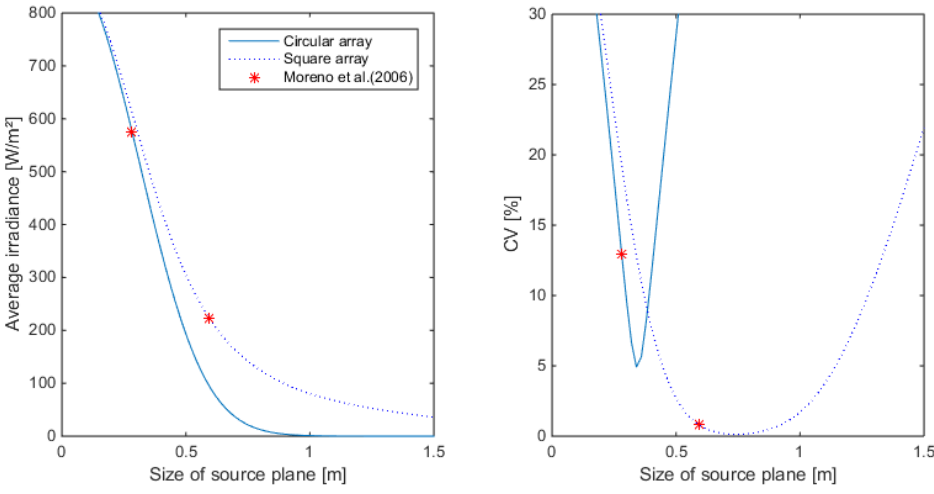
Figure 7. Average irradiance and Coefficient of Variation (CV) as a function of the source plane size for square and circular arrays of 36 LEDs. Simulations are done with the narrow beam lens. ( Left ): Average irradiance; ( Right ):